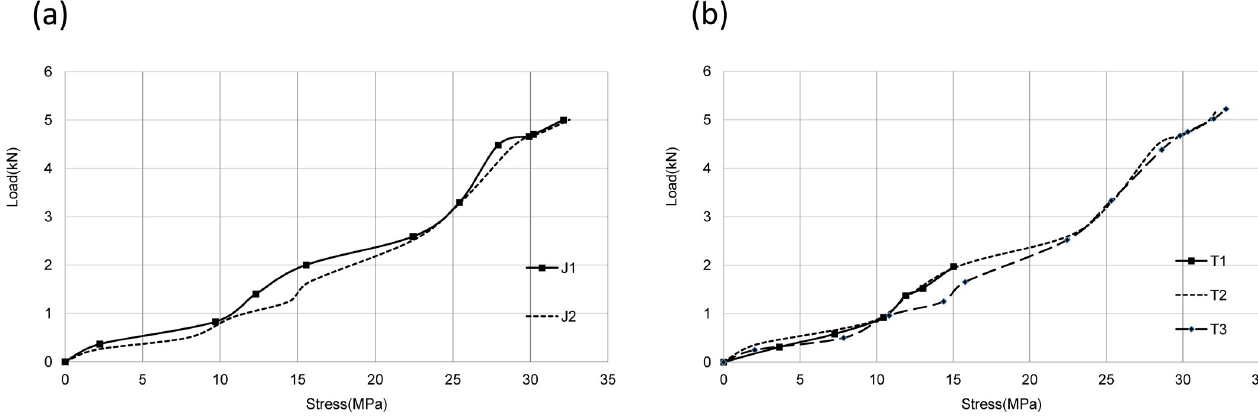
Fig 9. Load-stress curves. (a) J group;(b) T group.